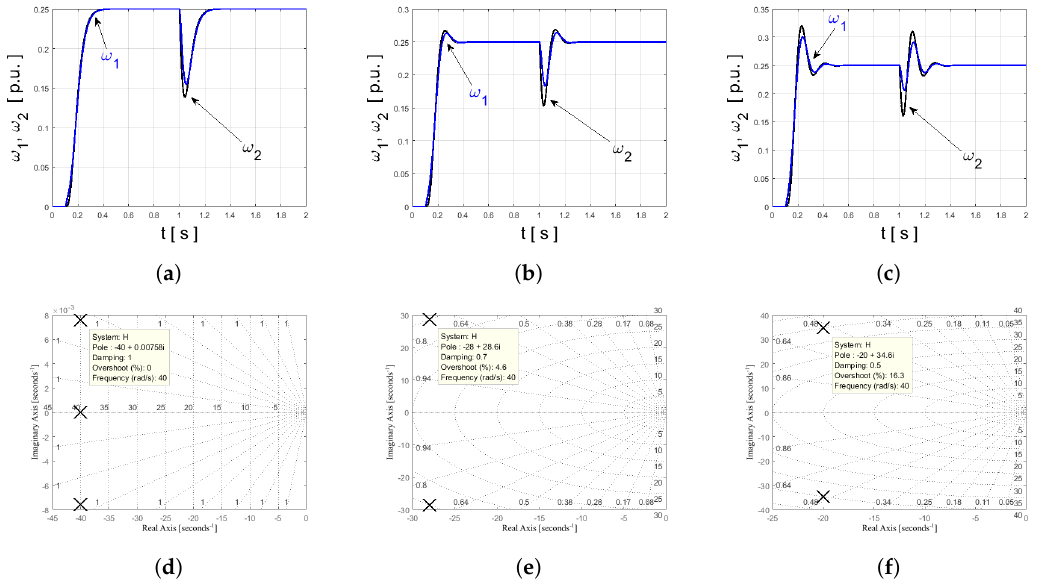
Figure 5. An influence of locus position on dynamics of transients: ( a , d ) ω 0 = 40 s − 1 and ξ r = 1; ( b , e ) ω 0 = 40 s − 1 and ξ r = 0.7; ( c , f ) ω 0 = 40 s − 1 and ξ r =